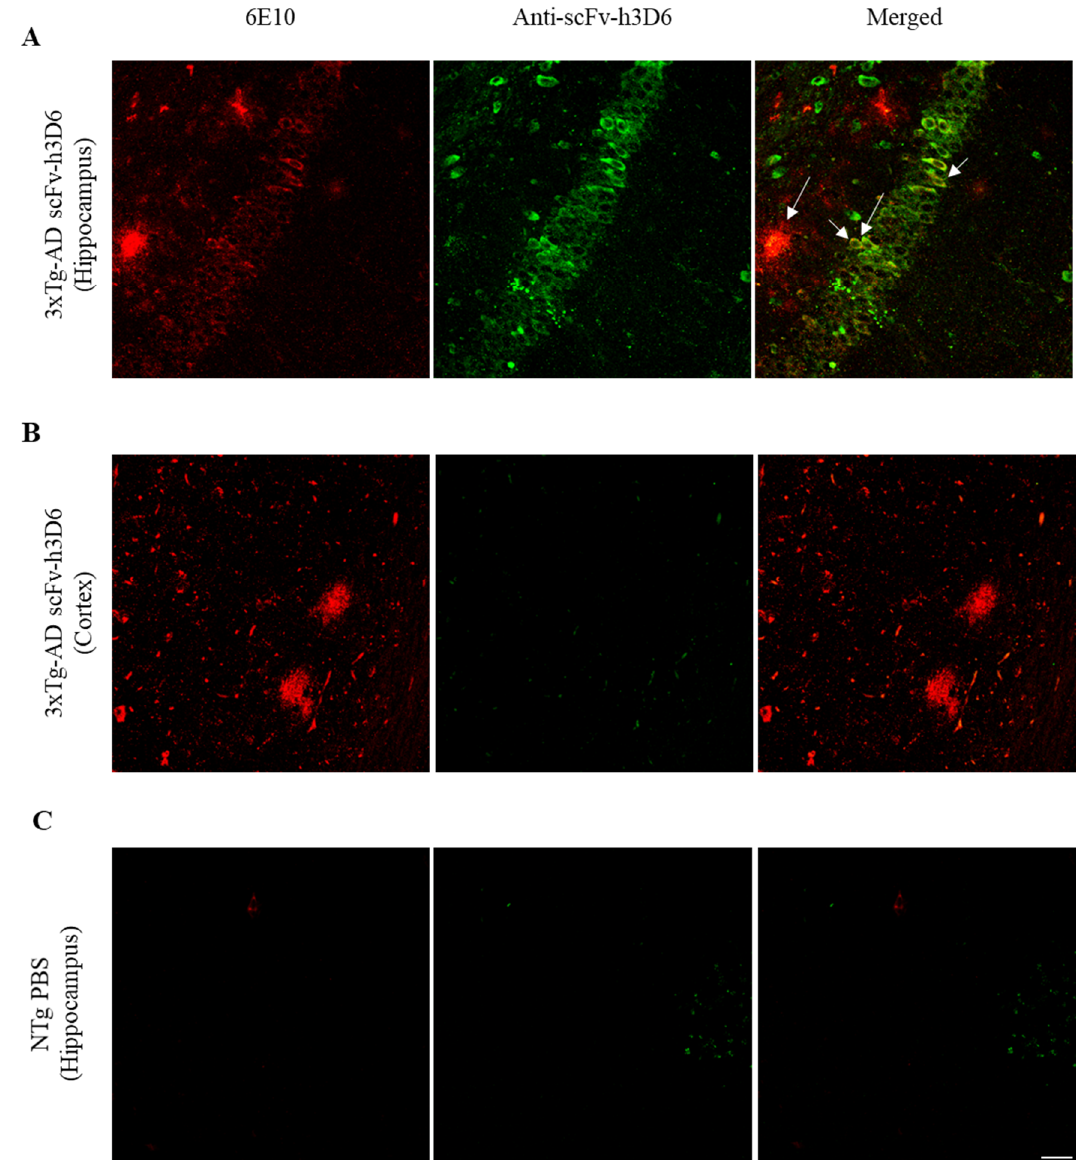
Figure 1. ScFv-h3D6 is mainly distributed throughout the hippocampus and co-localizes with extra and intracellular Aβ. Aβ in red (left), scFv-h3D6 in green (center), and Aβ/scFv-h3D6 merged (right). Arrows indicate scFv-h3D6-A β colocalization. ( A ) Labeling in 3xTg-AD hippocampus. ( B ) Labeling in 3xTg-AD cortex. ( C ) Labeling in the hippocampus of an untreated non-transgenic (NTg) mouse to determine the background noise. Scale bar, 25 µm.